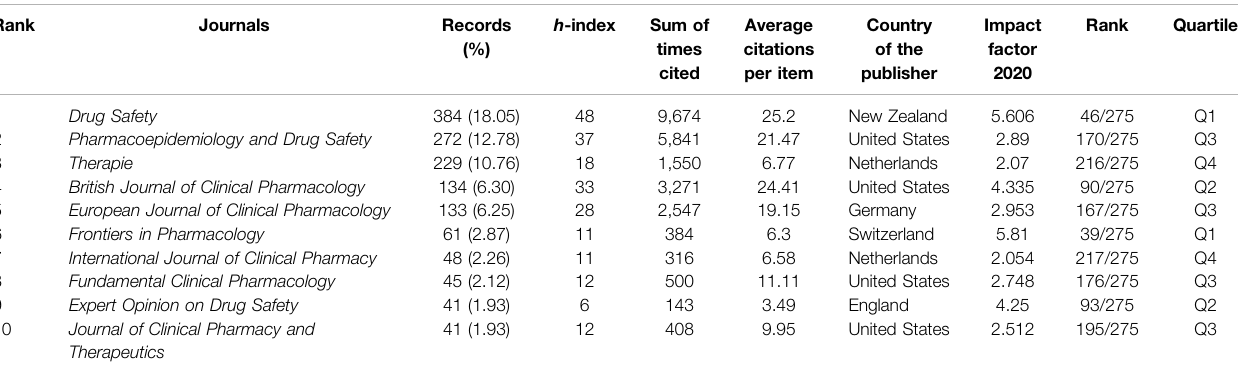
TABLE 2 | The top 10 high-yield journals on pharmacovigilance from 1974 to 2021. Rank Journals Records